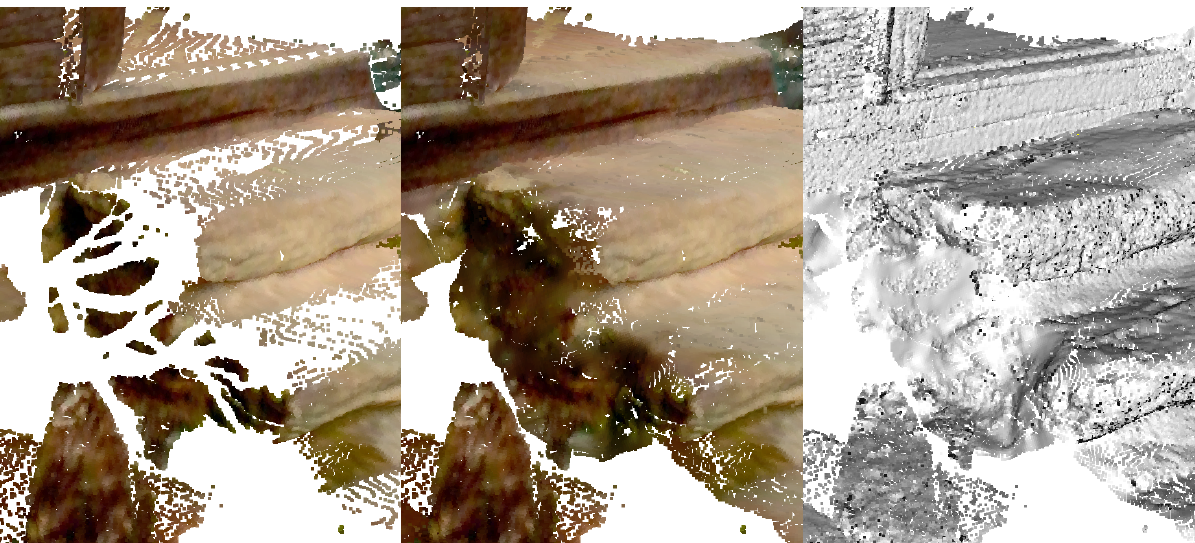
Figure 4. A close up of the Stairs segment. From left to right: the input scan, the inpainted colors, and estimated PCA normals of the inpainted surface. The dark outlier points were caused by the normal estimation. The visible cracks in the inpainted surface (middle) happen when the pixel grid of a back-projected depth image doesn’t have sufficient resolution to capture sharp elevation changes.